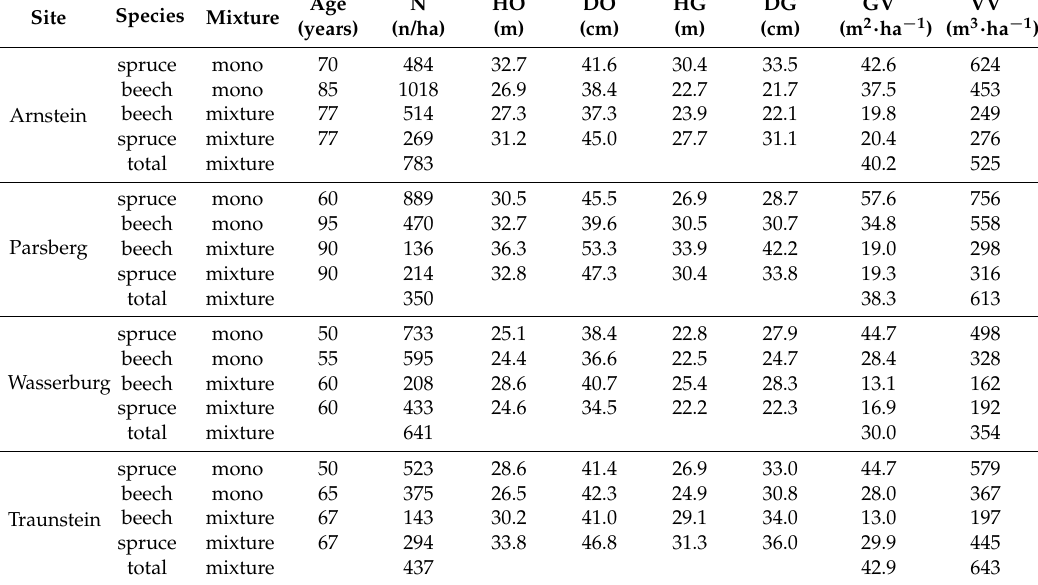
Table 2. Stand characteristics of the monospecific and mixed stands along the precipitation gradient from the northwest to the southeast of